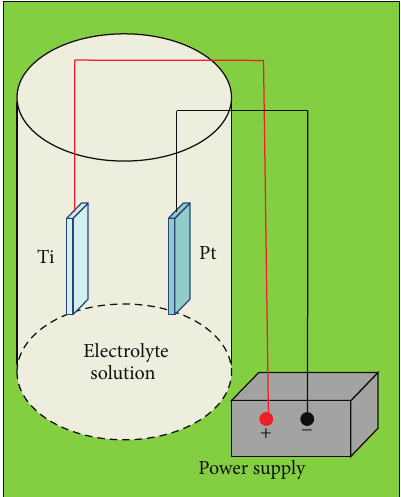
Figure 1: Schematic drawing of the electrochemical anodization setup. Fabrication variables include voltage, electrolyte concentra- tion, temperature, and